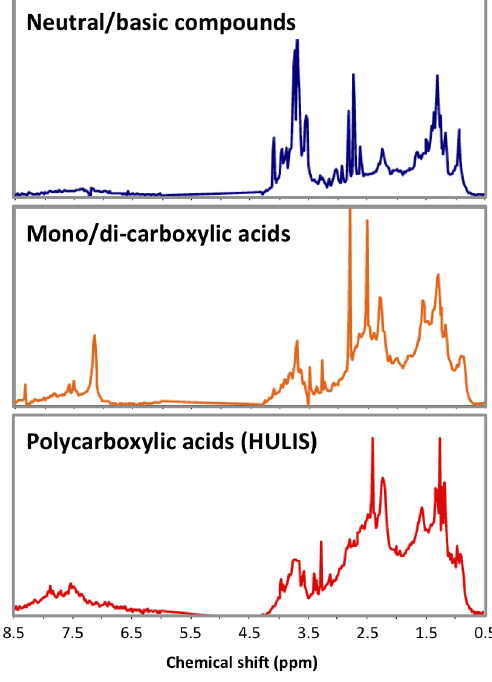
Figure 9. 1 H-NMR spectra of WSOC fractions isolated by anion- exchange